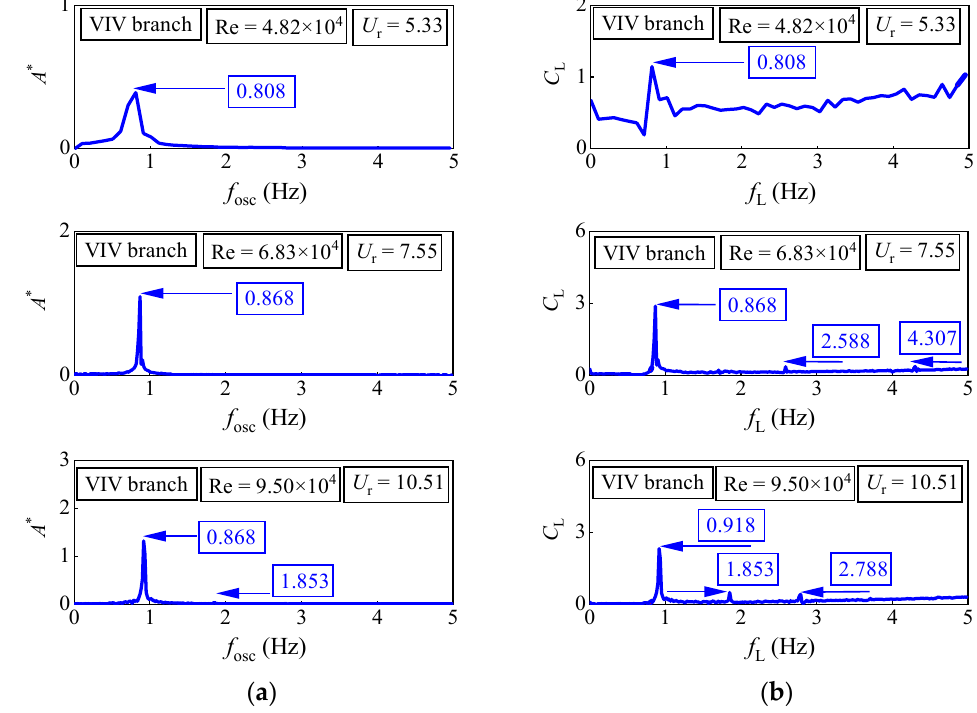
Figure 14. Spectral of Cir-T-Att with D = 0.10 m, R e = 4.82 × 10 4 ~1.15 × 10 5 . ( a ) Displacement spectral. ( b ) Fluid force spectral.